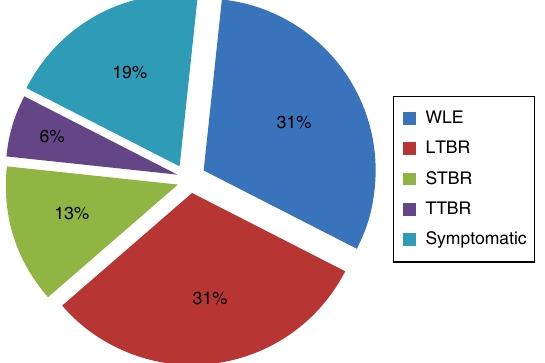
Performed treatment (WLE, wide local excision; LTBR, lateral temporal bone resection; STBR, subtotal temporal bone resection; TTBR, total temporal bone resection). Percentages of overall and disease-free survival. Overall